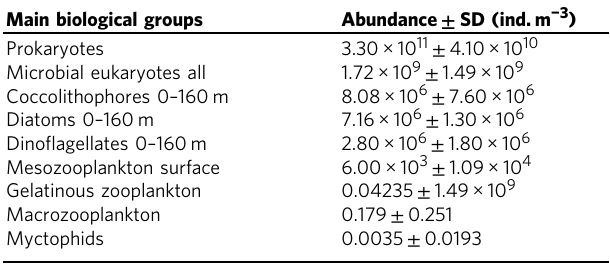
Table 3 Local abundance of main biological groups Main biological